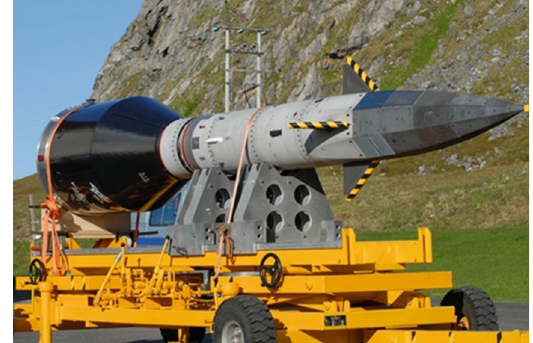
Figure 3: Payload of the SHEFEX II reentry vehicle upon rollout to the